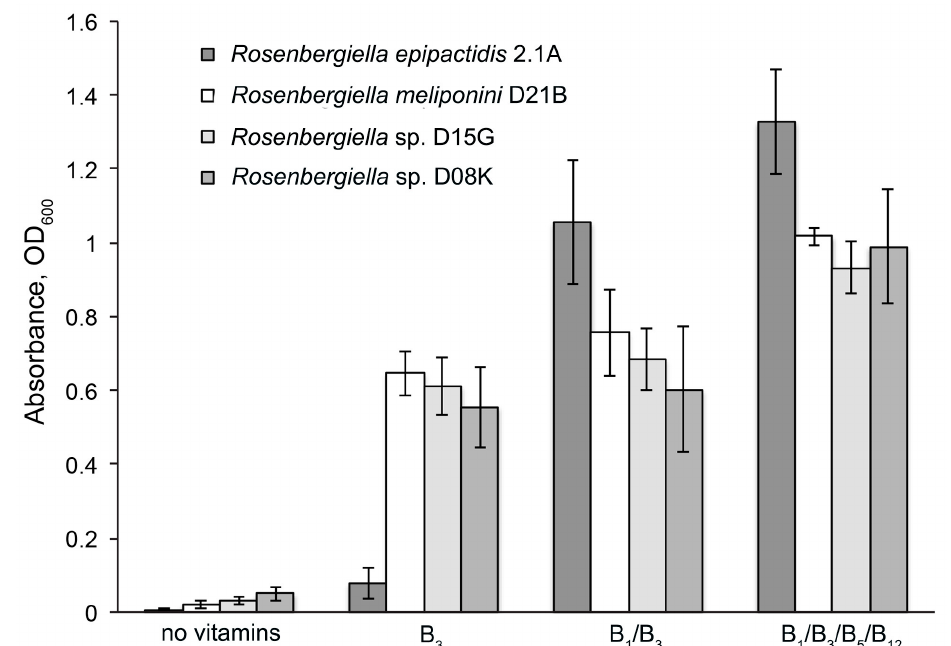
Figure 5. Vitamin B requirements of Rosenbergiella strains: R. epipactidis 2.1A required vitamin B 1 and B 3 for growth, while R. meliponini D21B, Rosenbergiella sp. D15G, and Rosenbergiella sp. D08K required only vitamin B 3 to grow in a minimal medium. No strain required vitamin B 5 or B 12 , although cell cultures sometimes attained higher densities when “non-essential” vitamins were